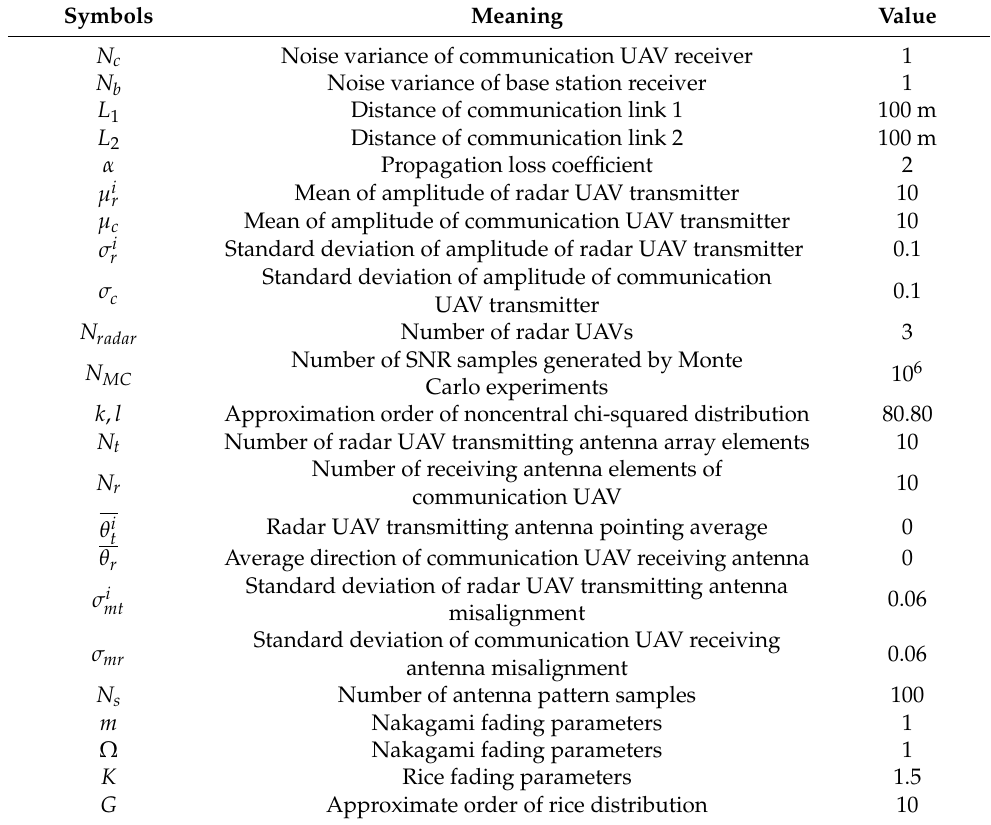
Table 1. Default parameters for numerical